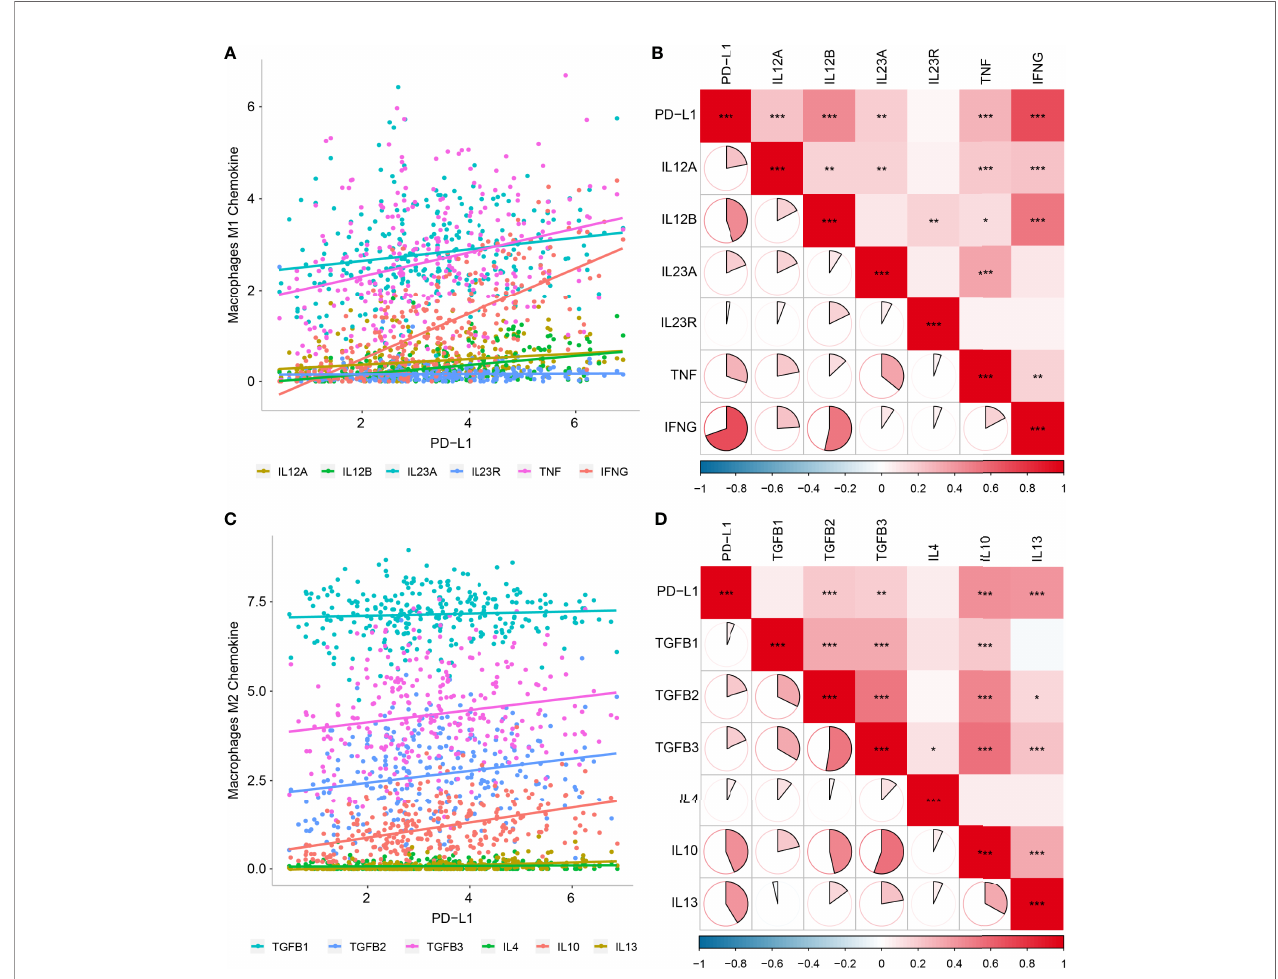
FIGURE 4 | Relationship between PD-L1 and macrophage-derived chemokines in OSCC samples. (A) Scatter plot showing correlation between PD-L1 and M1- derived chemokines. (B) Correlation between PD-L1 and M1-derived chemokines. (C) Scatter plot showing correlation between PD-L1 and M2-derived chemokines. (D) Correlation between PD-L1 and M2-derived chemokines. *P < 0.05; **P < 0.01; ***P <